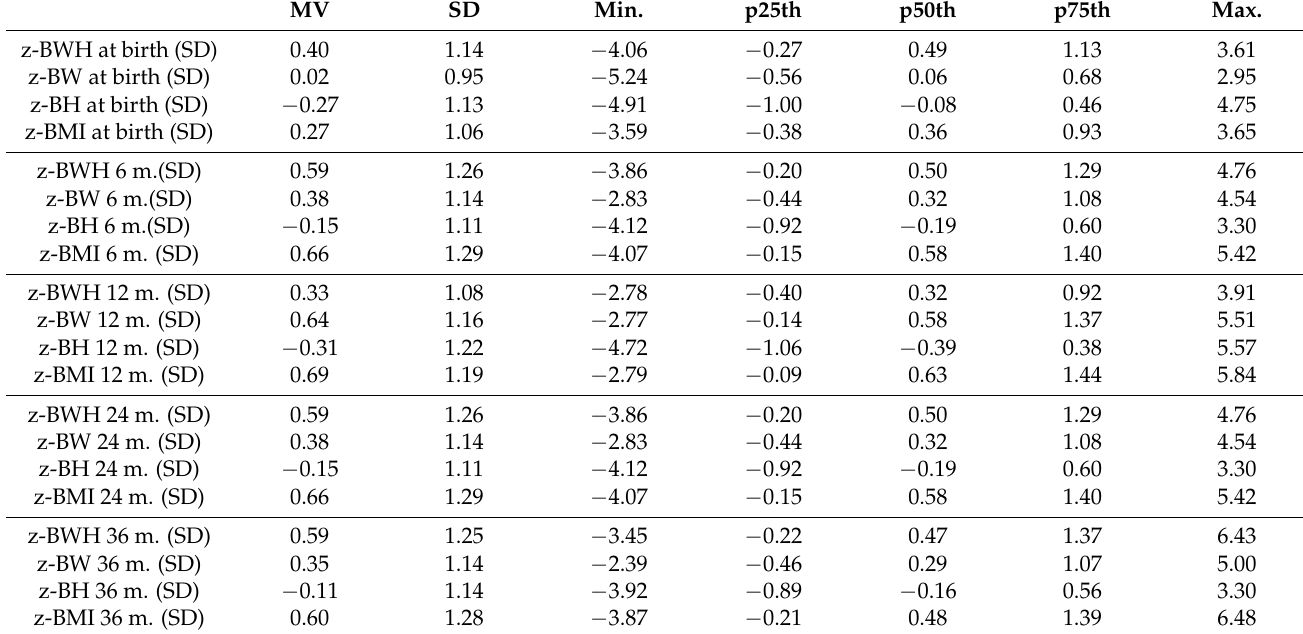
Table 2. Body size during growth ( n = 632).